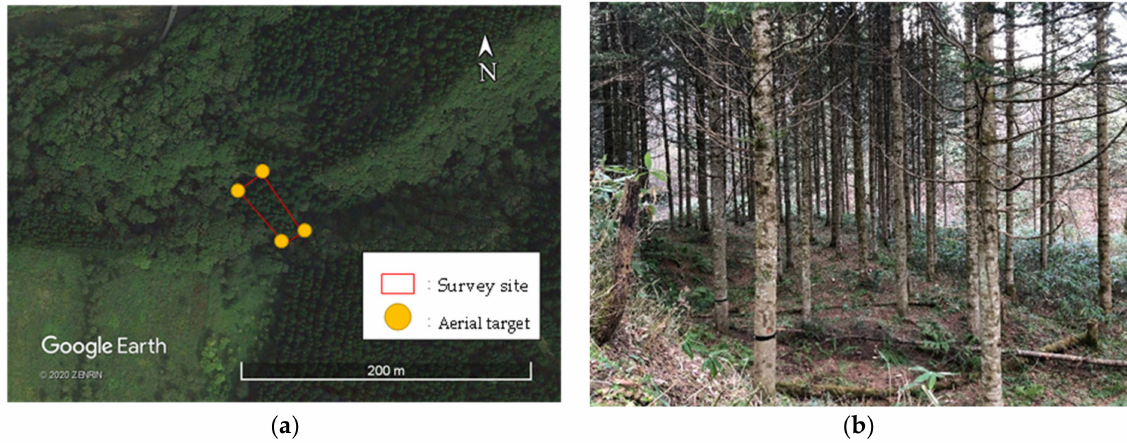
Figure 1. ( a ) Location of the survey site. Source Google earth; ( b ) the general landscape of the survey site. Source